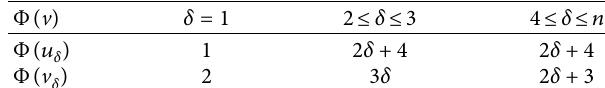
Table 13: Vertex labeling of Φ ( v ).